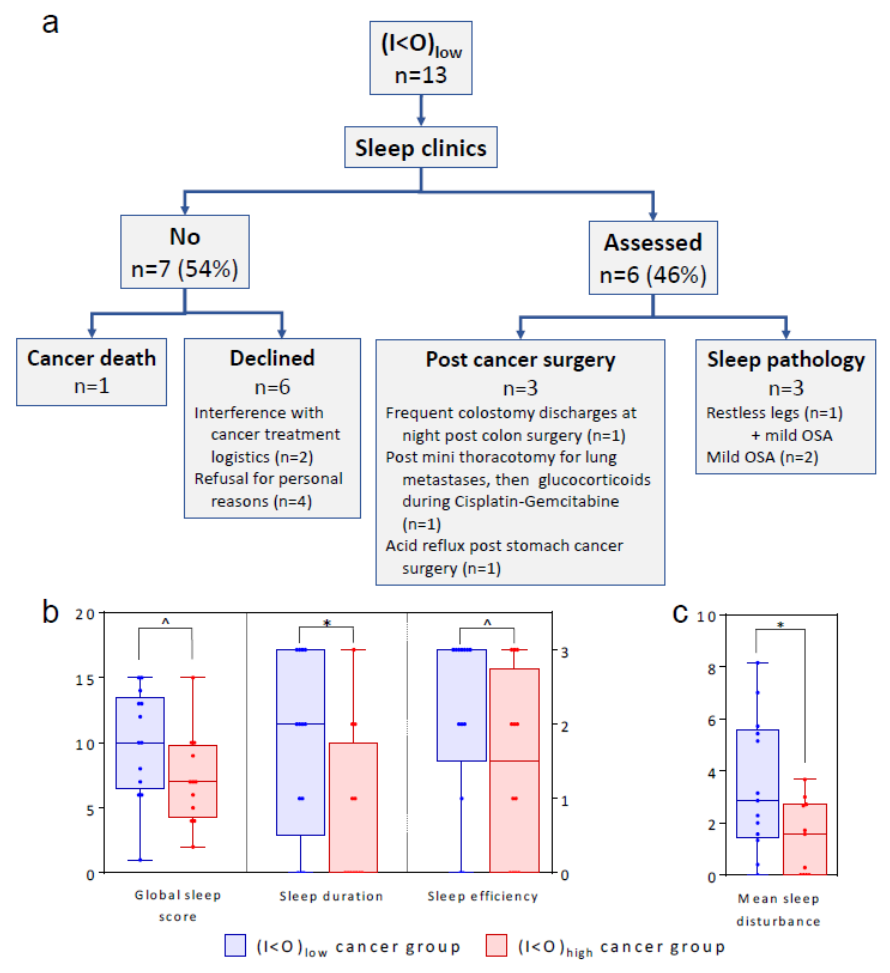
Figure 7. Sleep pathology assessment results and subjective sleep parameters. ( a ) Consort diagram of the sleep clinics assessment. OSA stands for obstructive sleep apnea. ( b ) Box plots showing distribution of global score and two selected components of the Pittsburgh sleep quality index (PSQI) in both I < O groups. ( c ) Box plots of the mean score of the sleep disturbance symptom from the MDASI questionnaire in both I < O groups. In ( b , c ), bars represent the extremes and bold lines inside the box plots plot median levels. Values for each individual are plotted as jittered dots to better show the distribution. Levels of significance: * 0.01 < p ≤ 0.05; ˆ 0.05 < p ≤ 0.1 (two-tailed Welch’s modified t -test).